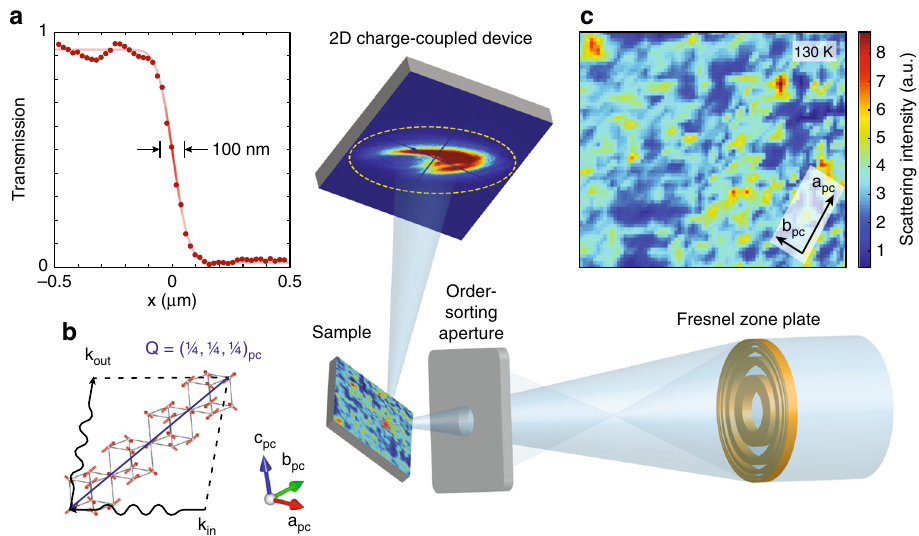
Fig. 1 Experimental setup and nanoscale antiferromagnetic landscape in NdNiO 3 . The combined use of a Fresnel zone plate and an order sorting aperture delivers a ~ 100 nm focused soft X-ray spot at the sample. The magnetic Bragg diffraction patterns are visualized with a fast area detector. a Knife edge scan, demonstrating a spot size of around 100 nm at 852.5eV (Ni- L 3 resonance). b The sample was oriented to intercept the antiferromagnetic diffraction peak at Q AFM = [¼, ¼, ¼] pc (reciprocal lattice units in pseudocubic notation) arising from ordering within the Ni spin sublattice 38,39 . c The spatial map of magnetic scattering intensity exposes a highly inhomogeneous electronic landscape at the nanoscale. Arrows indicate the local pseudocubic crystallographic orientation. Each arrow length spans 1 μ m in the sample frame of reference. Notice that in this scattering geometry, owing to the sample surface not being normal to the incident X-ray beam, additional geometric factors need to be accounted for when converting lateral beam translation footprint (de fi ned in lab frame) onto the sample surface (sample of different magnetic domains. As the ordering vector Q AFM = (¼, ¼, ¼) pc has eight equivalent direction in the pseudocubic cell, the spiral magnetic con fi guration shown in Fig. 1b lifts the